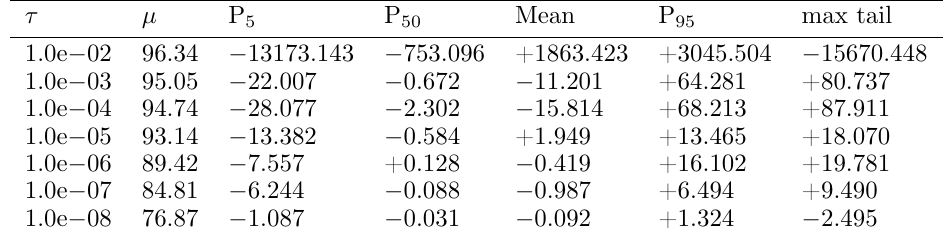
Table 6. Error on k ∞ in pcm after lossy compression by truncated HT on the UGd dataset with separate matrices M per nuclide and reaction.